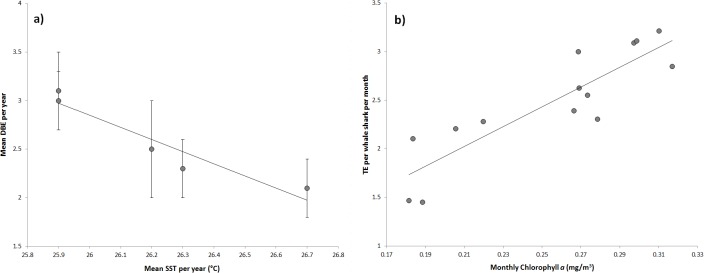
Relationships between a) mean DBE (days between encounters) and the mean SST (sea surface temperature) per year ± standard errors and b) total encounters (TE) per whale shark per month and the monthly concentration of chlorophyll a.6a) Mean DBS = -1.3SST + 35.4, R2 = 0.90, p = 0.018; 6b) TE = 10.20CHLa – 0.12, R2 = 0.77, p = 3.34e-5.